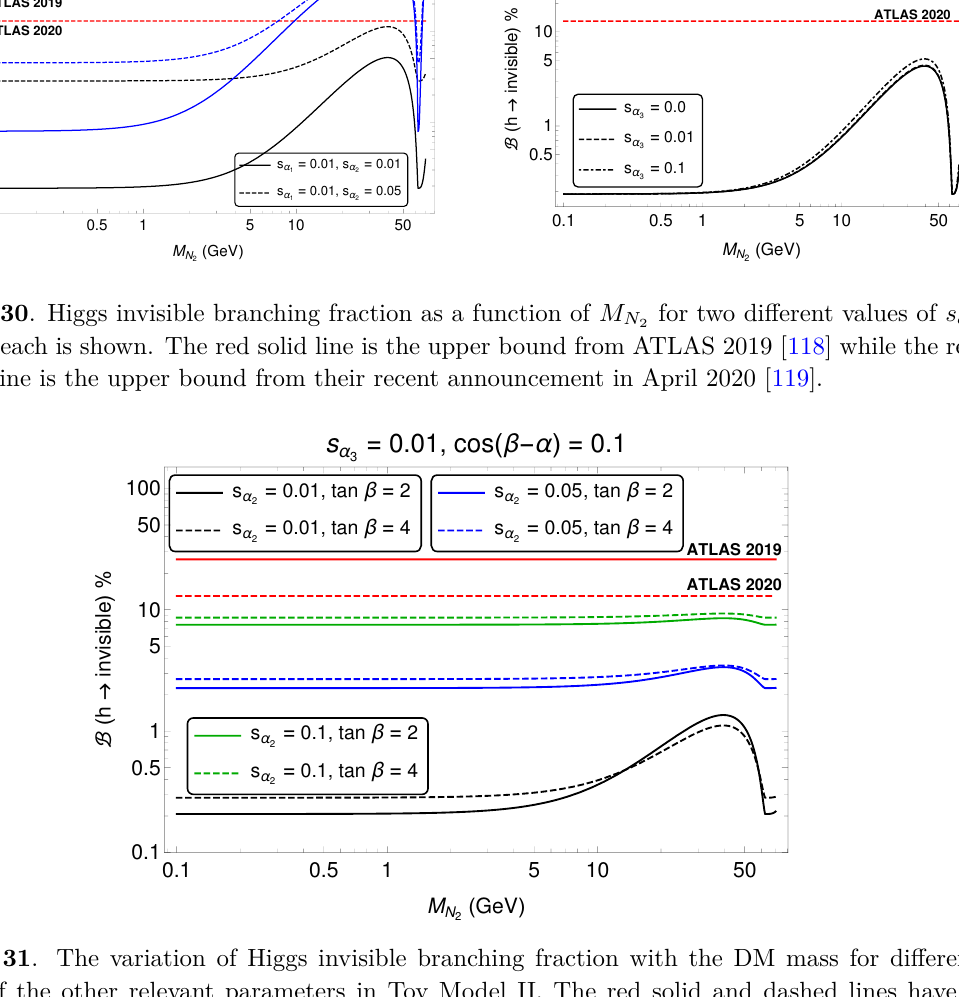
Figure 31 . The variation of Higgs invisible branching fraction with the DM mass for different values of the other relevant parameters in Toy Model II. The red solid and dashed lines have a similar description as given in figure